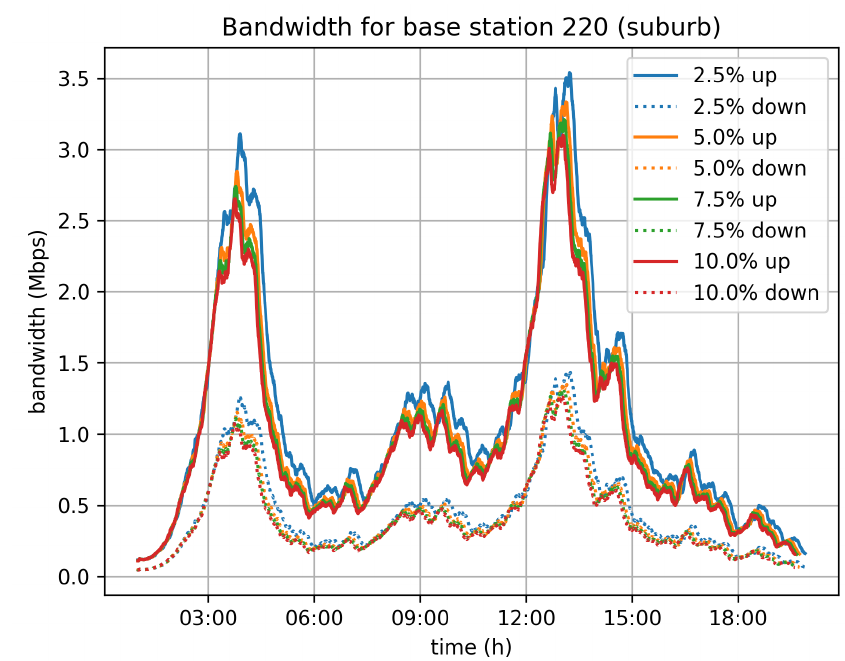
Figure 13. Neighborhood base station bandwidth requirements.